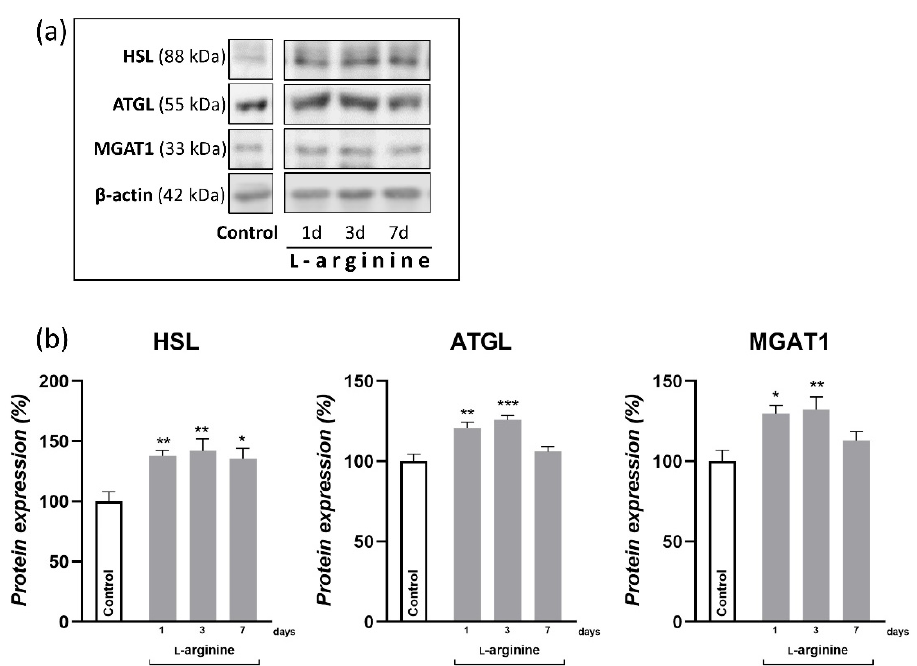
Figure 3. L -arginine increases fatty acid turnover in retroperitoneal white adipose tissue (rpWAT). Protein content of hormone sensitive lipase (HSL), adipose triglyceride lipase (ATGL), and mono- acylglycerol O-acyltransferase 1 (MGAT1) in rpWAT of rats receiving either drinking water or 2.25% L -arginine · HCl in drinking water for 1, 3, and 7 days, determined by Western blot. The signals from representative Western blots are shown ( a ). Data obtained after quantification of specific bands and expressed as % of the control group taken as 100% represent the mean ± SEM ( b ). Each band is representative of six pooled samples per group. Experiments were repeated in triplicate. Data were quantified as described in the Methods. * Comparison between control and L -arginine-treated group; * p < 0.05, ** p < 0.01, *** p < 0.001.